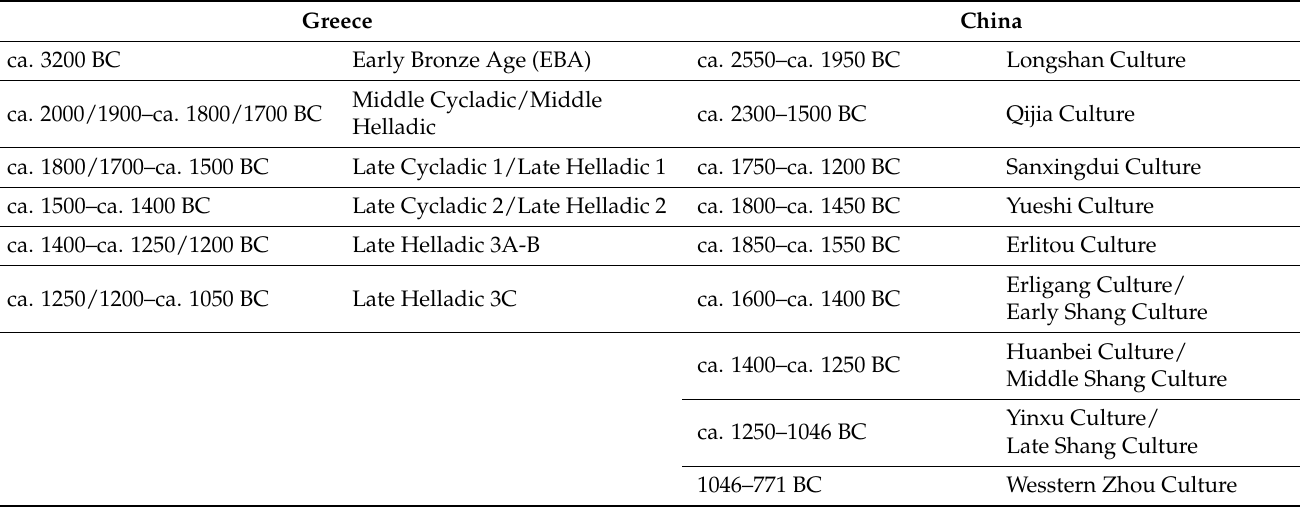
Table 1. Table showing basic chronological comparison of Greece and China (dates from Bintliff, 2012; Underhill, 2013)